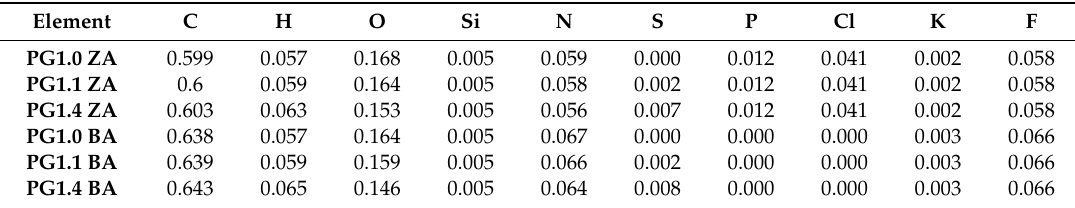
Table 6. Calculated mass shares of individual